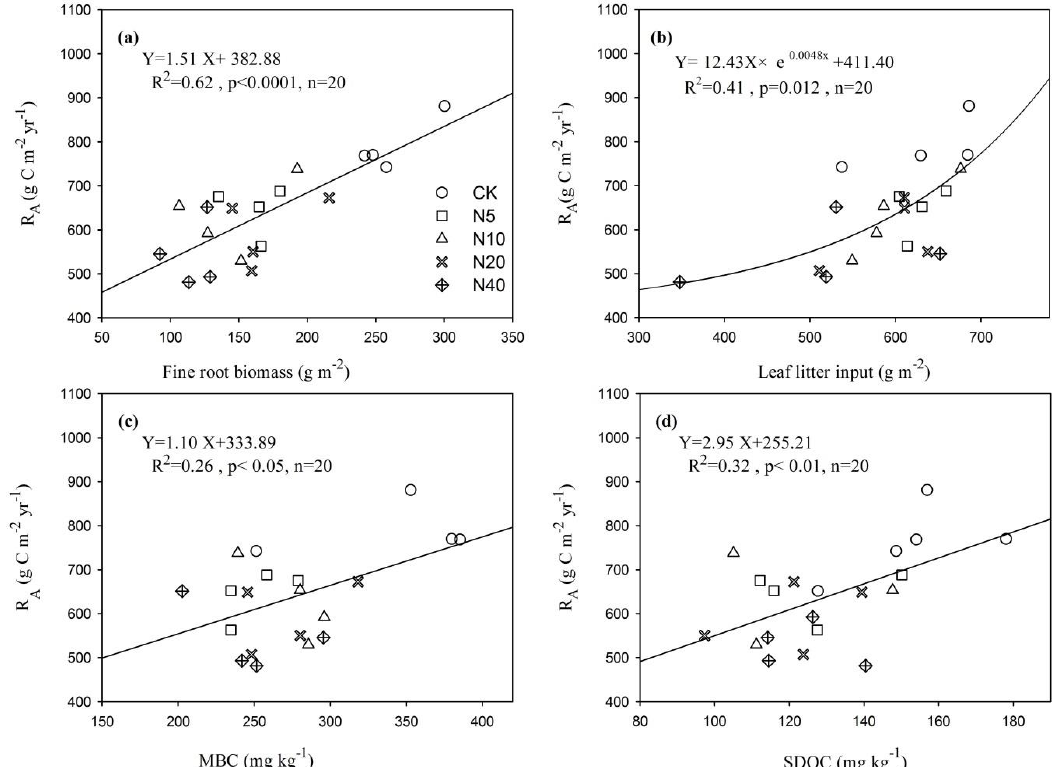
Figure 4. Relationship between annual cumulative soil respiration rate (R A ) and fine root biomass ( a ), leaf litter input ( b ), MBC content ( c ), and SDOC content ( d ).